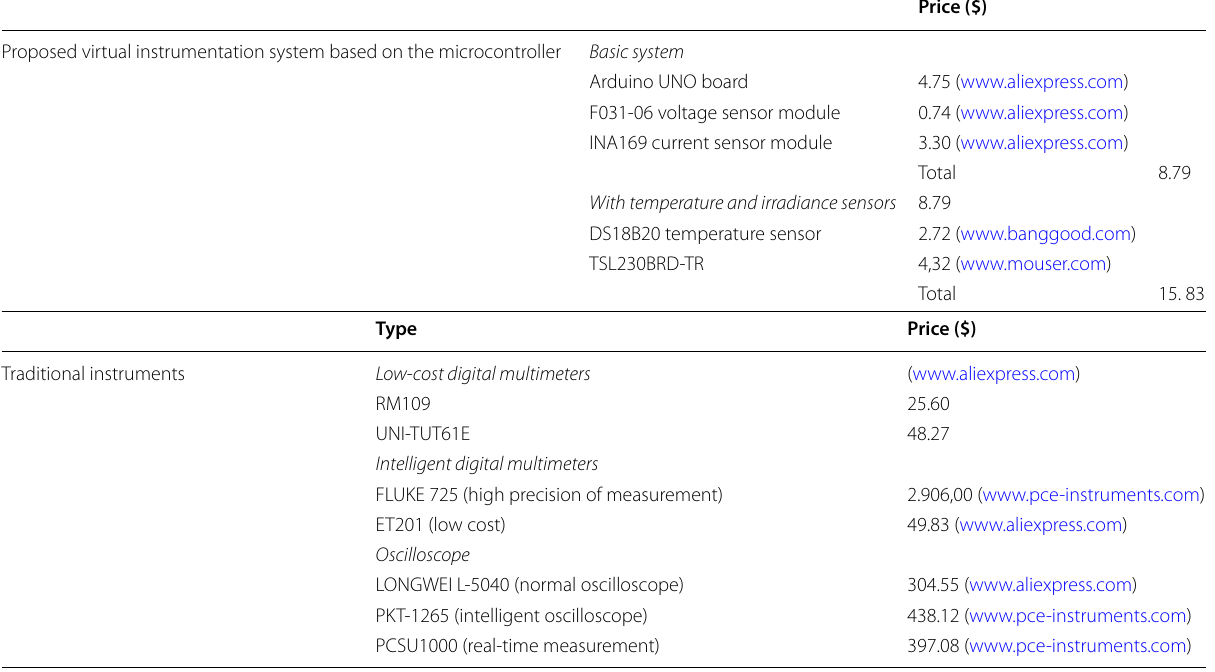
Table 8 Price of the proposed virtual instrumentation system in comparison with that of traditional instruments